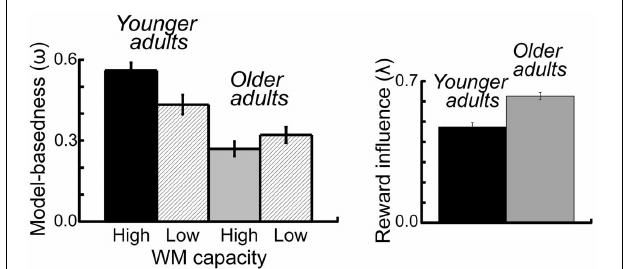
FIGURE 5 | Left panel: Mean parameter estimates for the omega ( ω -) parameter, displayed separately for the two age groups and the two WM capacity groups. The ( ω -) parameter reflects the relative contribution model-based and model-free mechanisms to first stage choice behavior. Right panel : Mean parameter estimates for the lambda ( λ -) parameter, displayed separately for the two age groups. The ( λ -) parameter reflects the direct influence of reward on the previous trial on first stage choice behavior. Error bars reflect the standard error of the mean (s.e.m.).